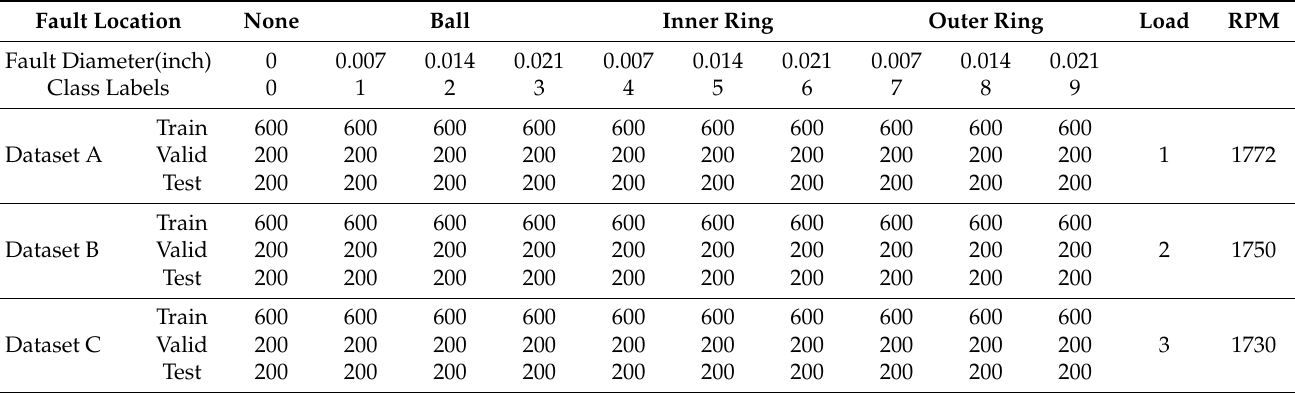
Table 3. Dataset constructed based on CWRU bearing